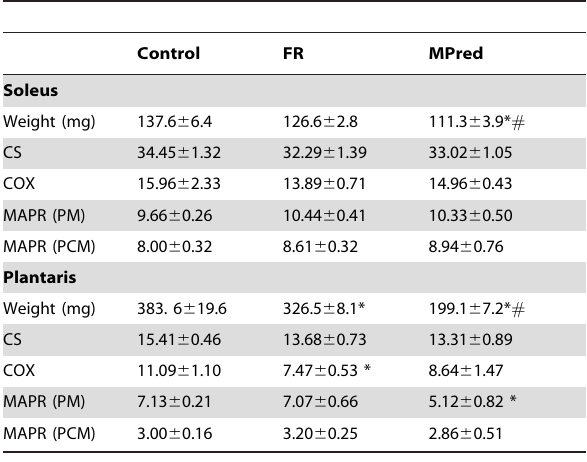
Table 1. Muscle weight, mitochondrial enzyme activity,